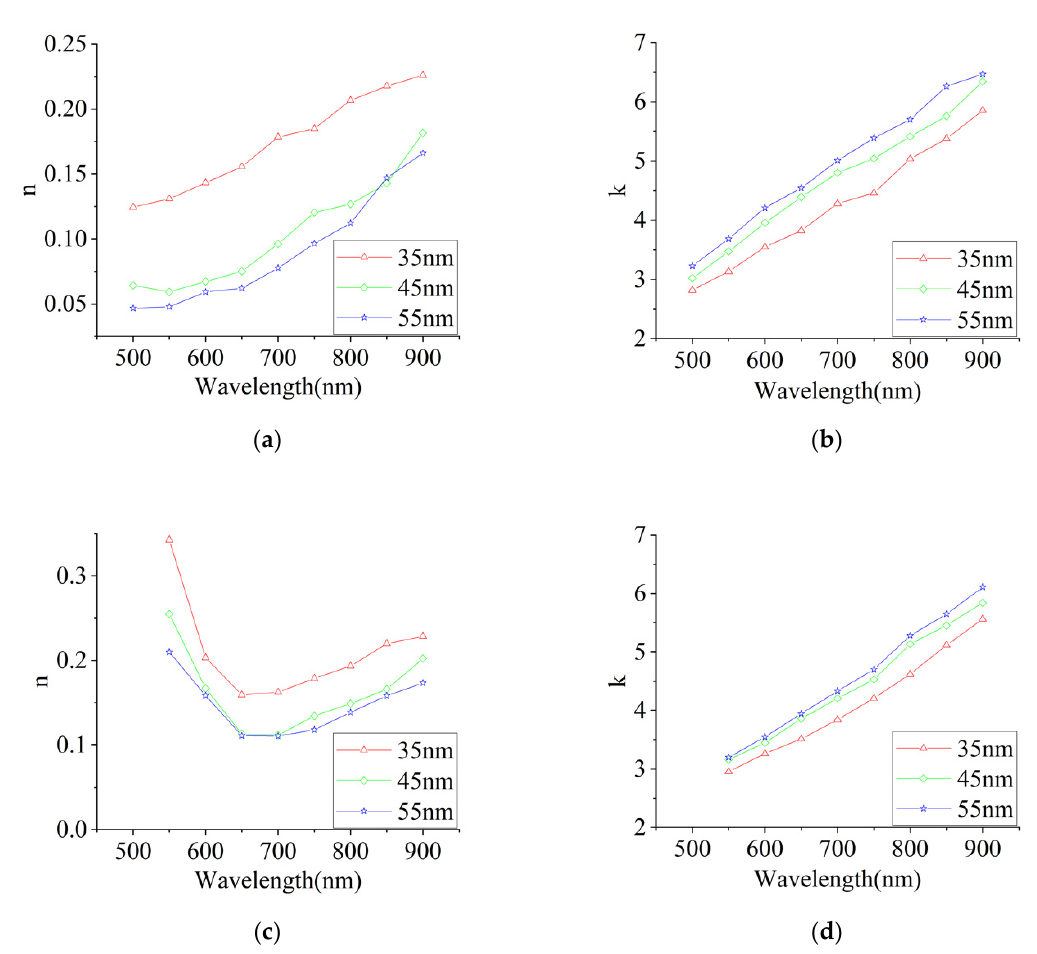
Figure 9. The refractive index and extinction coefficient spectrums of silver ( a,b ) and gold ( c,d ) films for different thicknesses.